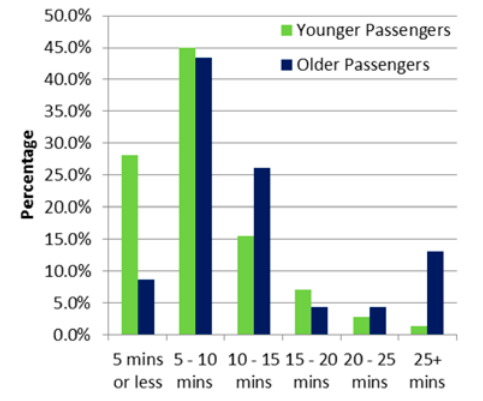
Fig. 4. Clearance times by